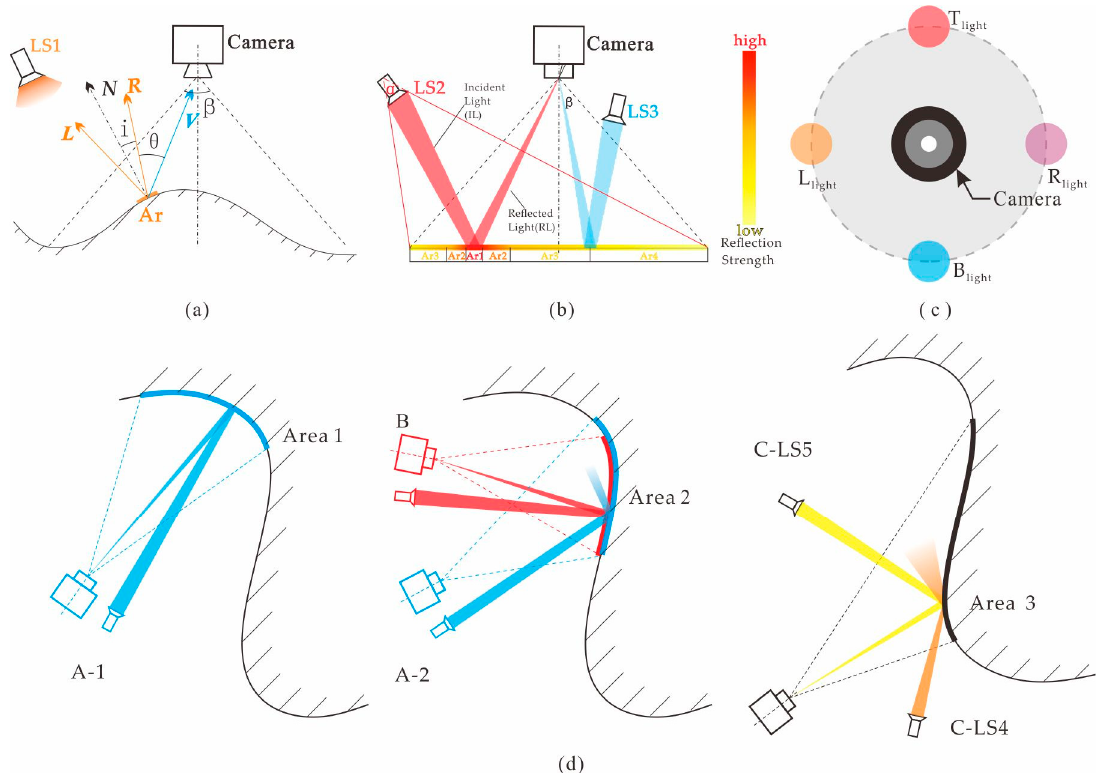
Figure 3. Non-Lambertian free surface lighting effect: ( a ) reflection diagram of phone model; ( b ) characteristic of high reflection at different light sources LS2 and LS3 on the plane surface; ( c ) schematic diagram of lighting device; ( d ) the influence of the positional relationship between camera, light source and surface on the reflection performance.